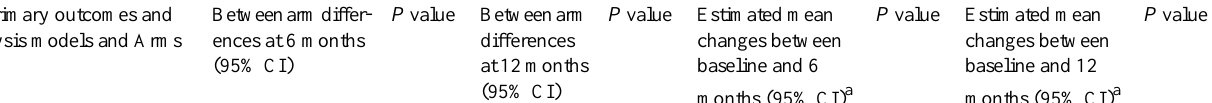
Table 3. Effectiveness of the intervention on coprimary